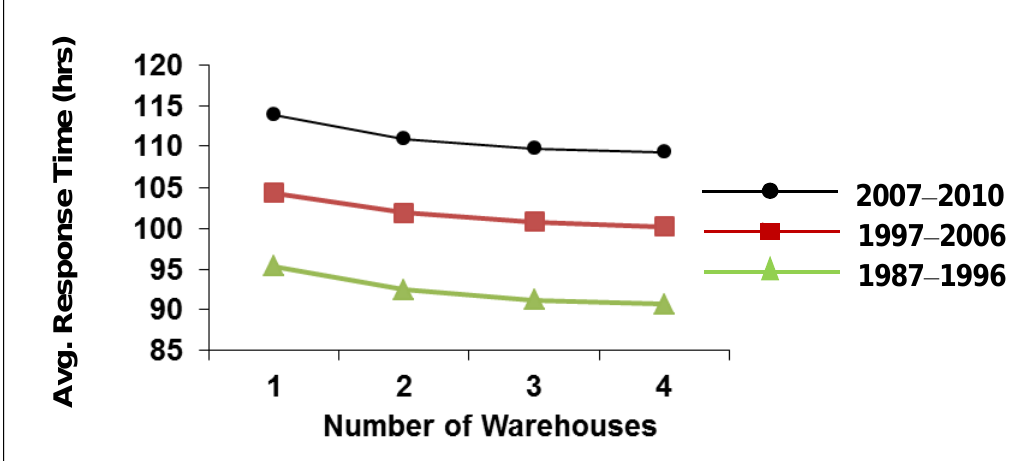
Figure 3. The change in Average Emergency Response